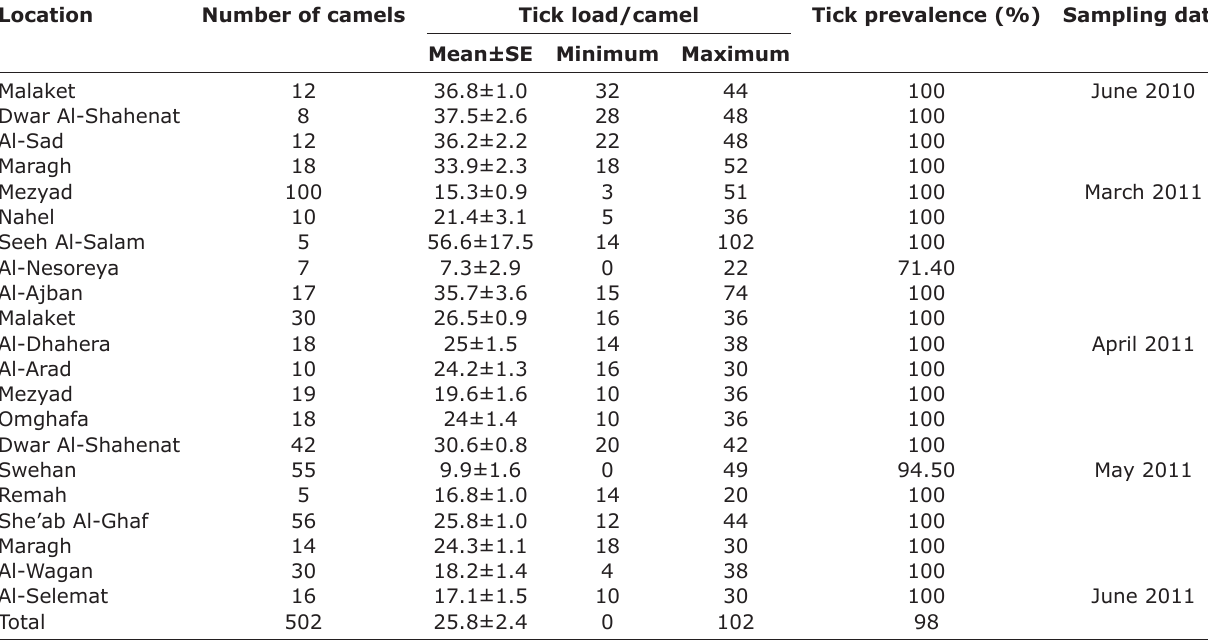
Table-1: Prevalence and load of Hyalomma dromedarii ticks on camels in Al Ain, United Arab Emirates. Location Number of camels